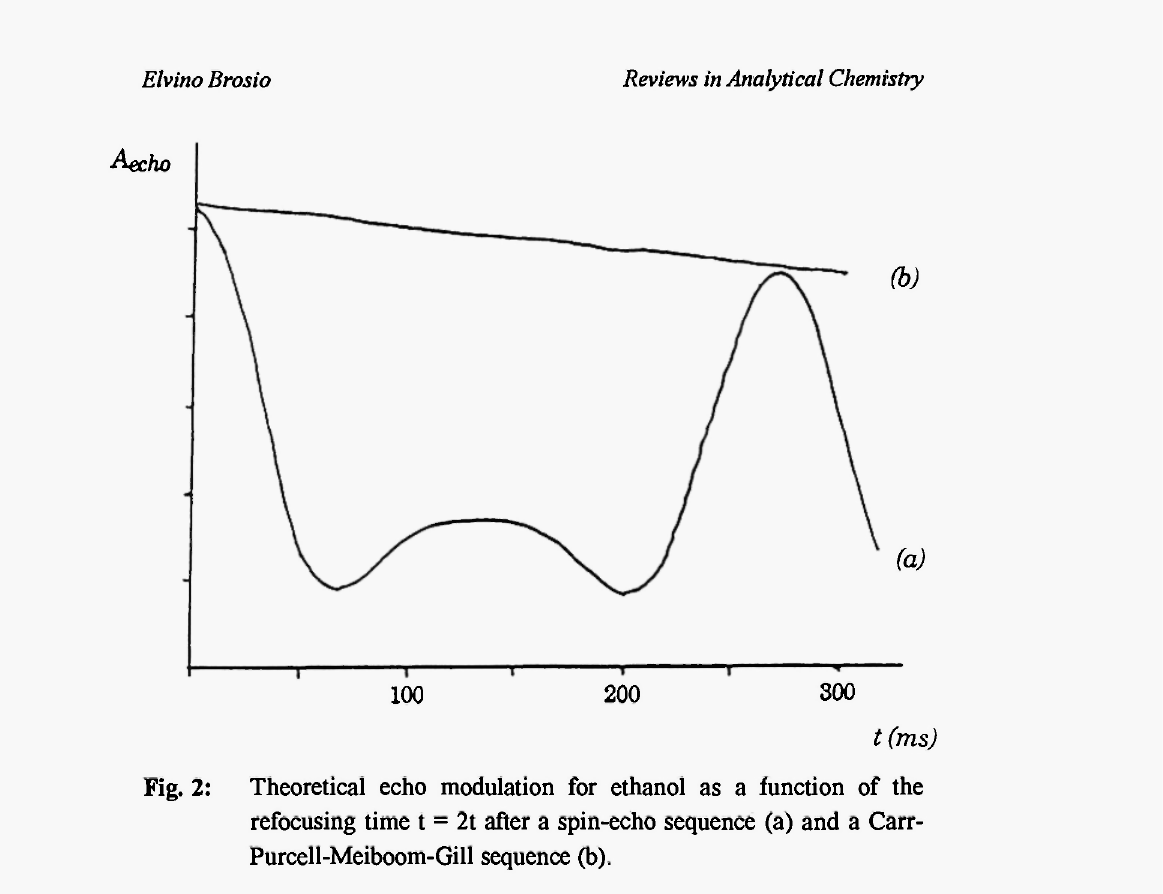
Fig. 2: Theoretical echo modulation for ethanol as a function of the refocusing time t = 2t after a spin-echo sequence (a) and a Carr- Purcell-Meiboom-Gill sequence During a spin-echo sequence (90°-x/2-180°-x/2-echo acquisition), the presence in the sample of molecules with a J .H coupling system leads to H incomplete refocusing of the magnetization at a time that is dependent on the J value /25/. For ethanol the amplitude modulation is maximum for t = 1/2 J ~ 68 ms, and at this value, the methyl and methylene protons of ethanol no longer contribute to the total magnetization A^ho (Figure 2, curve a). After a CPMG multiecho sequence [90°-τ~ 180°-(2τ-180°) -acquisition], n J modulation disappears and the magnetization ACPMO is proportional to the proton density of the medium (Figure 2, curve b). Therefore, at time t = 68 ms, the difference (Δ) between the unmodulated (ACPMO) and the modulated (Aecho) echoes is proportional to the proton density of the CH and CH 3 2 protons, in other words, to the alcohol content of the solution. A linear relationship between the percentage of ethanol in the volume and the NMR data has been found, such that the ethanol content in aqueous solution may be predicted with an average error of 0.5% (v/v).